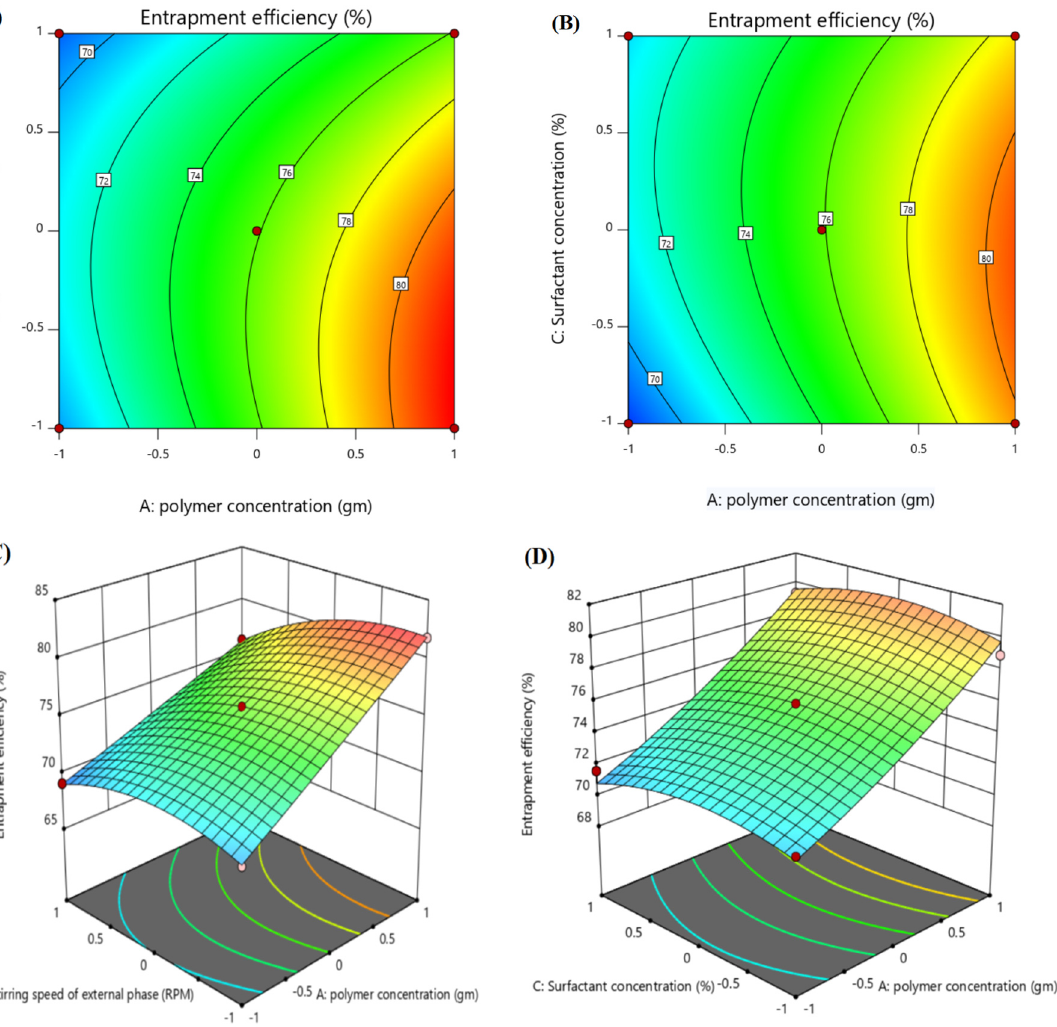
Figure 4. Contour surface plots showing the effect of independent variables (factors) on the entrap- ment efficiency (Y3) of optimized ACR-PCL-NPs. ( A ) impact of polymer concentration and stirring speed on entrapment efficiency, ( B ) impact of polymer concentration and surfactant concentration on entrapment efficiency and 3D plots, ( C ) impact of stirring speed and polymer concentration on en- trapment efficiency, ( D ) impact of polymer concentration and surfactant concentration on entrapment